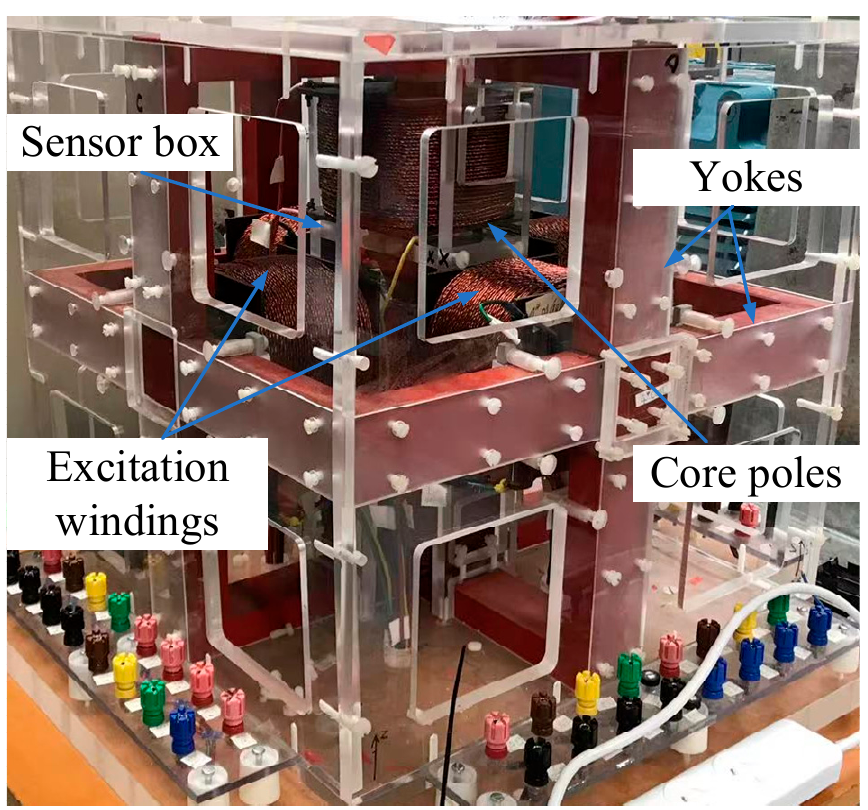
Figure 2. A photo of the 3D vectorial magnetic property measurement system.